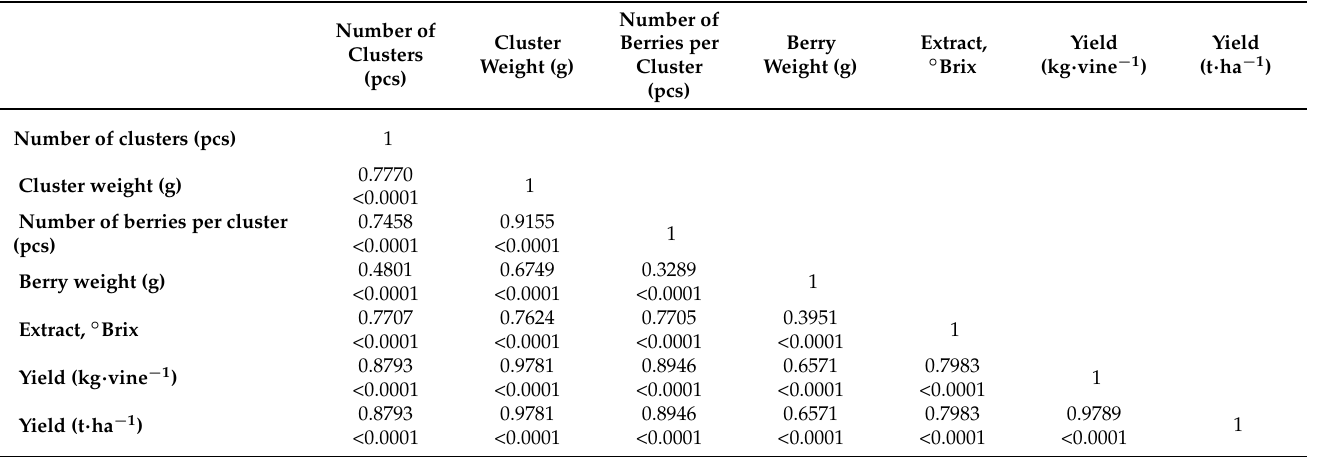
Table 3. Pearson correlation for quantity and quality parameters of Regent grapevine yield regardless of the year of research and the type of rootstock.